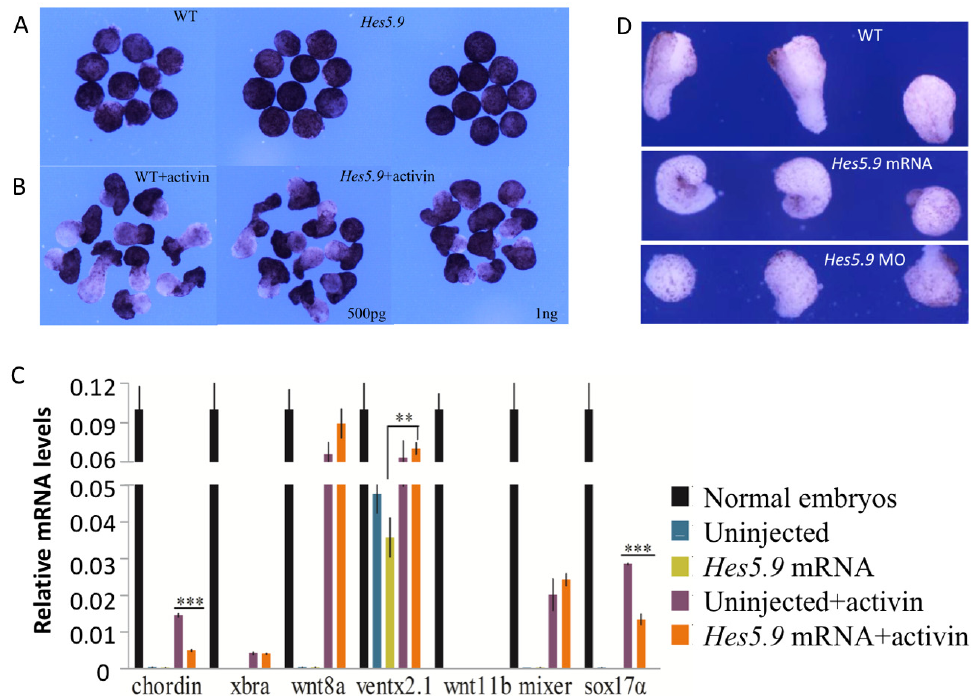
Figure 8. The Hes5.9 inhibited cell fate specification and cell migration. A range of 500 pg-1 ng Hes5.9 mRNA was injected into the destined dorsal cells at the 4-cell stage. Animal caps were dissected from wild type or Hes5.9 overexpressed embryos at stage 8 and then cultured in 0.1 × MMR without ( A ) or with ( B ) activin (25 pg / mL), and these explants were captured until the equivalent of stage 17. ( C ) The expression patterns of the marker genes were determined by RT-qPCR. ( D ) The dorsal marginal zone (DMZ) explants were dissected at stage 10.25 and a picture taken at stage 17, ** p < 0.01; *** p < 0.001.